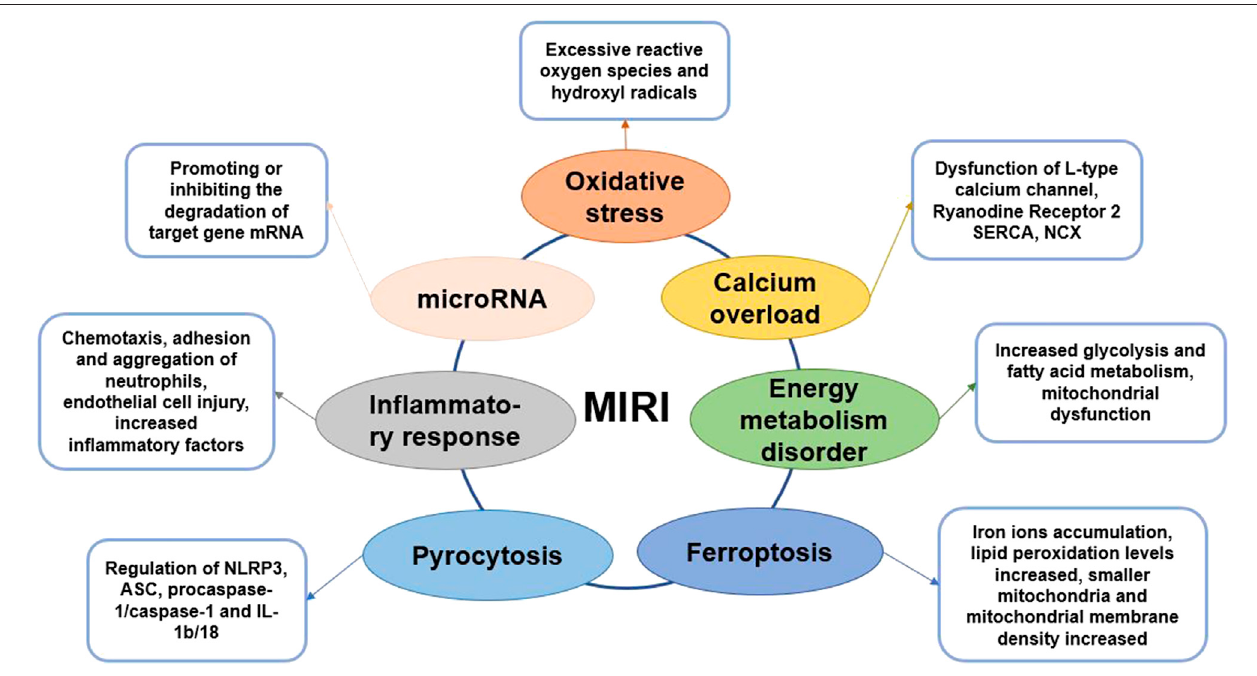
FIGURE 1 | Graphical summary of MIRI